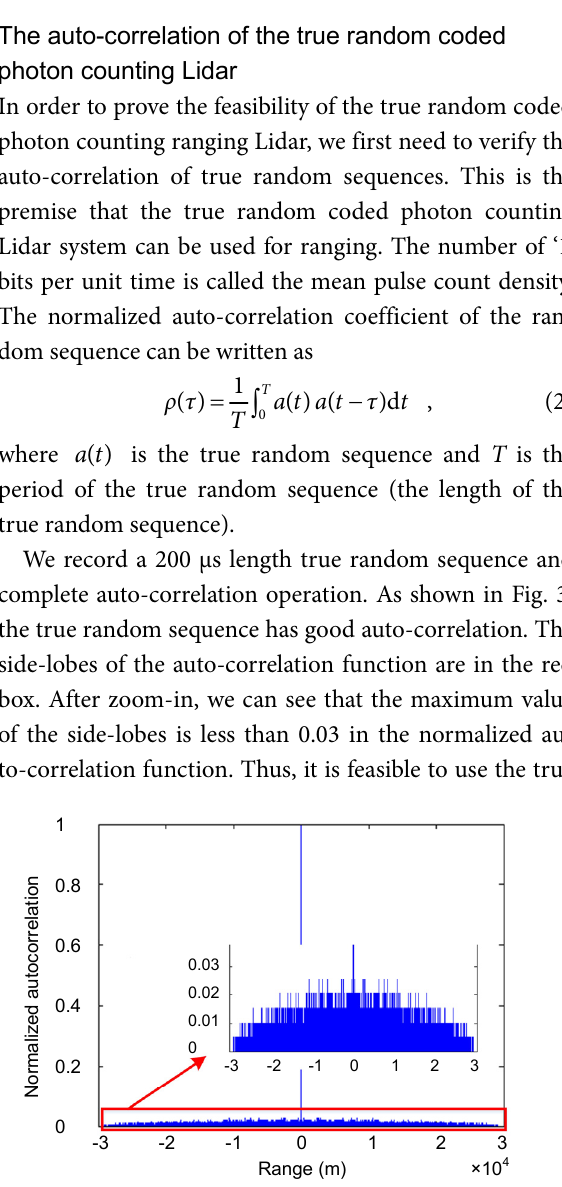
Fig. 3 | Normalized auto-correlation function of the true